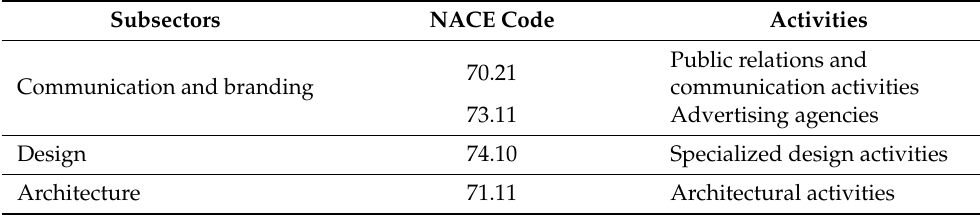
Table 3. Cross-border specialization in the Creative Industries